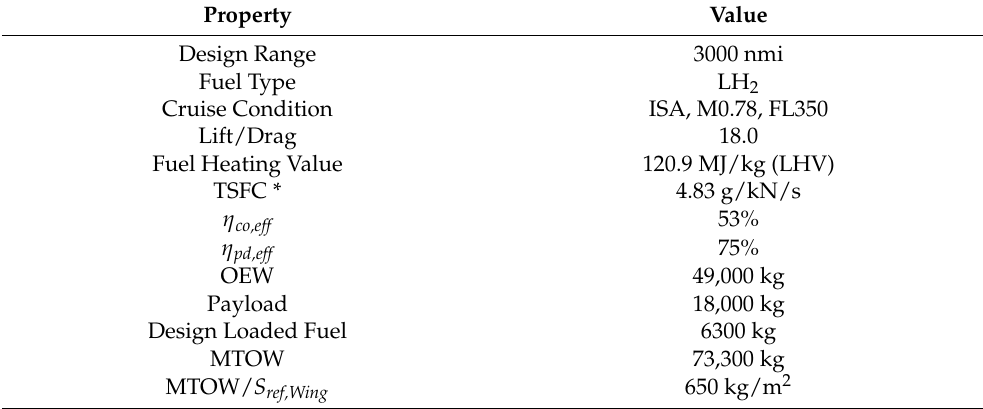
OEW 49,000 kg Payload 18,000 kg Design Loaded Fuel 6300 kg MTOW 73,300